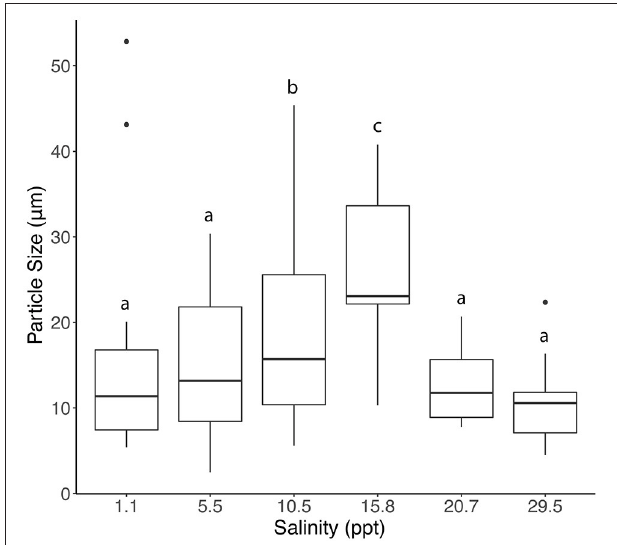
FIGURE 2 | Average particle size, measured by microscopy, for each of six stations. Lowercase letters indicate statistically significant differences between stations. a is significantly different from c but not b, b is not significantly different from a or c. Significance was determined via a Tukey HSD test (Supplementary Table